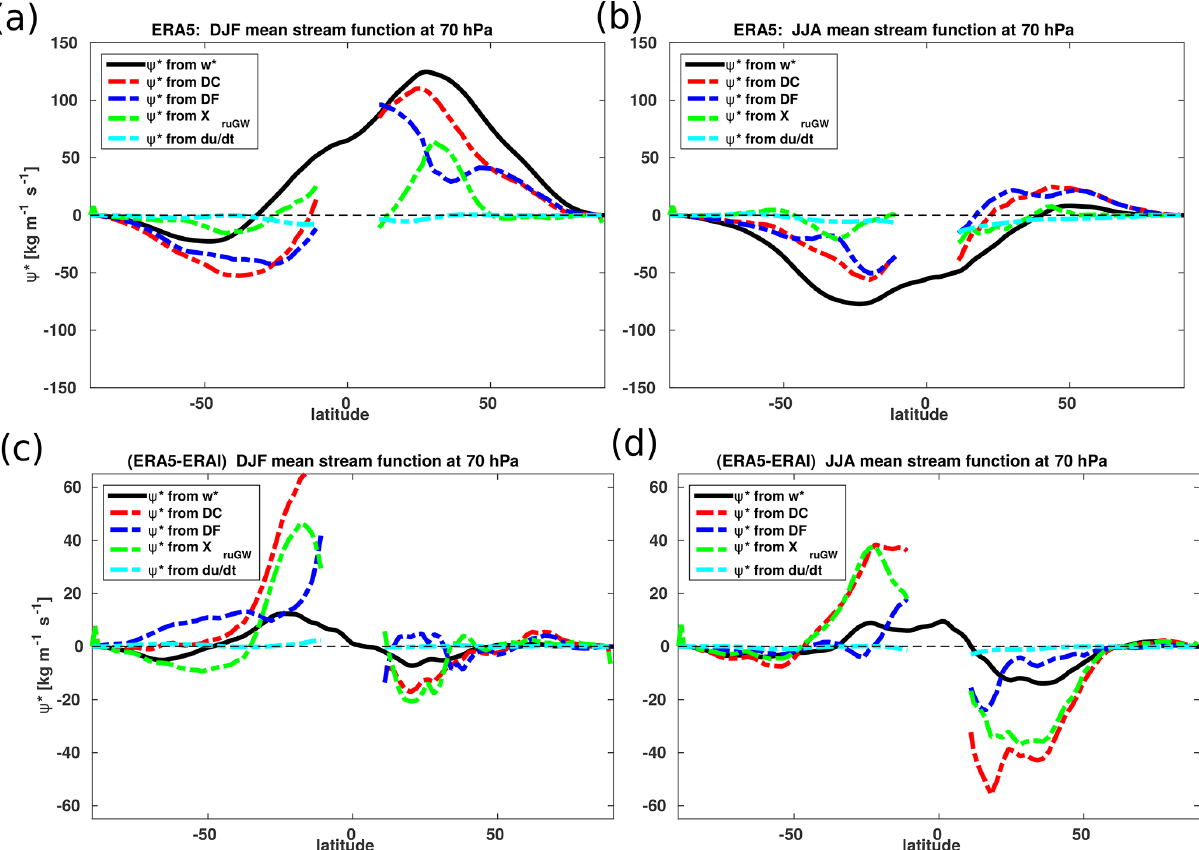
Figure 11. DJF (a, c) and JJA (b, d) seasonal mean variations of the mass stream function ( ψ ∗ in kgm − 1 s − 1 ) from the ERA5 (a, b) and the associated differences between ERA5 and ERA-Interim (c, d) for the 1979–2018 time period. The ψ ∗ is calculated from the w ∗ , resolved wave drag (DF), unresolved wave drag ( X urGW ), and wind tendency using the downward control (DC) principle (Haynes et al.,